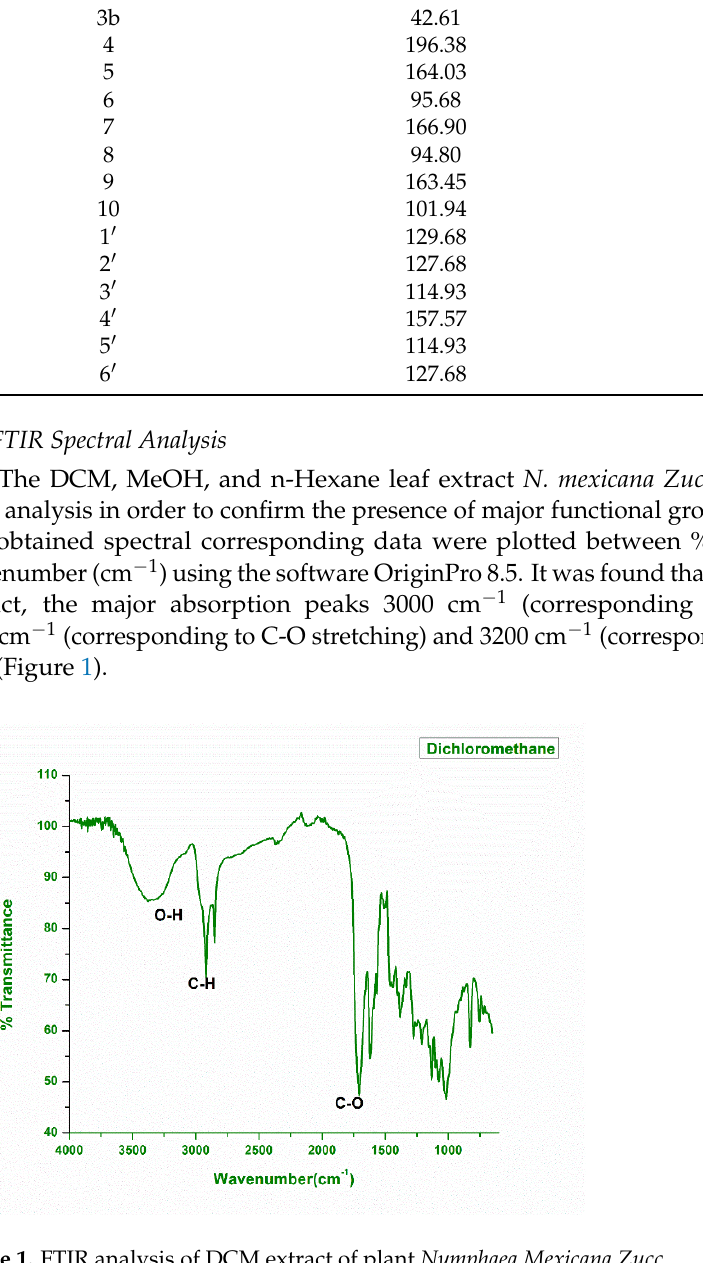
Table 1. 13 C and 1 H NMR chemical shift values (ppm) of naringenin.